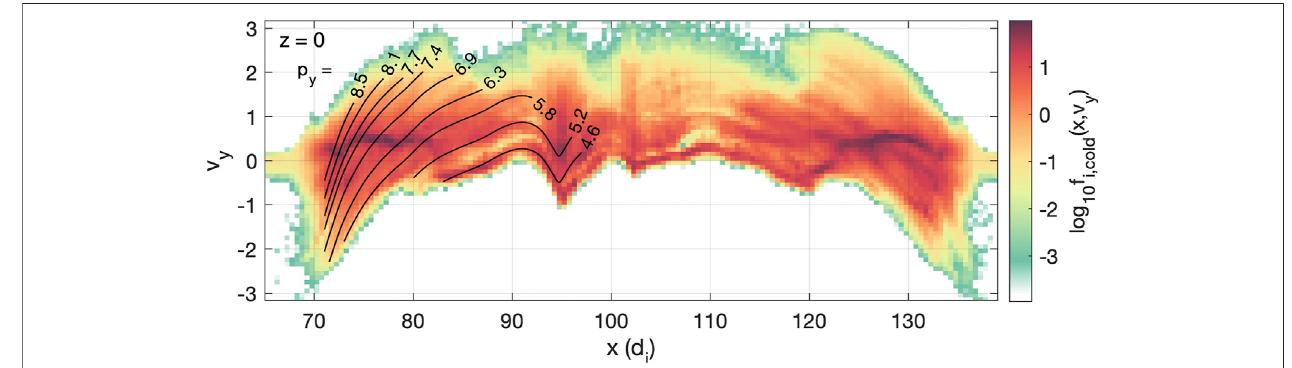
FIGURE9| Reducediondistribution f ( x , v y )at z (cid:1) 0,and t (cid:1) 120.Thelinesshowcontoursofconstantcanonicalmomentum p y (cid:1) m i v y + qA y ,whichwellexplainsthe overall phase space structure ( x , v y ) of the thermalized exhaust. Since v y ( t (cid:1) 0) (cid:1) 0, ions with the same p y originated from the same fl ux tube, de fi ned by a given A y . Ions with v y > 0 ( < 0) are currently downstream (upstream) of their original fl ux